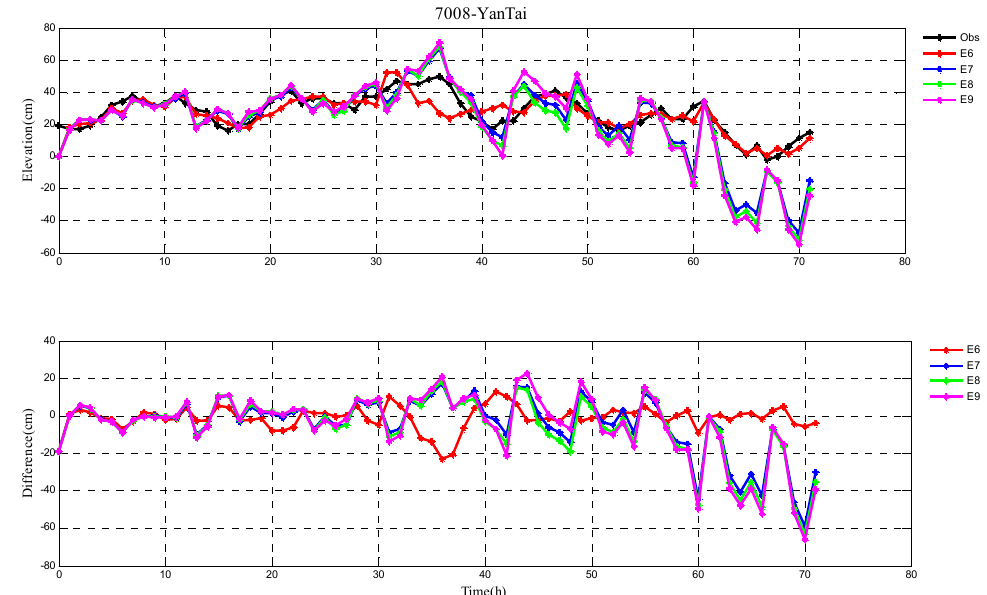
Figure 10. Storm surge elevations in four experiments (E6–E9), observations (black line) ( top ), and their differences ( bottom ) during Typhoon 7008 at LongKou station.